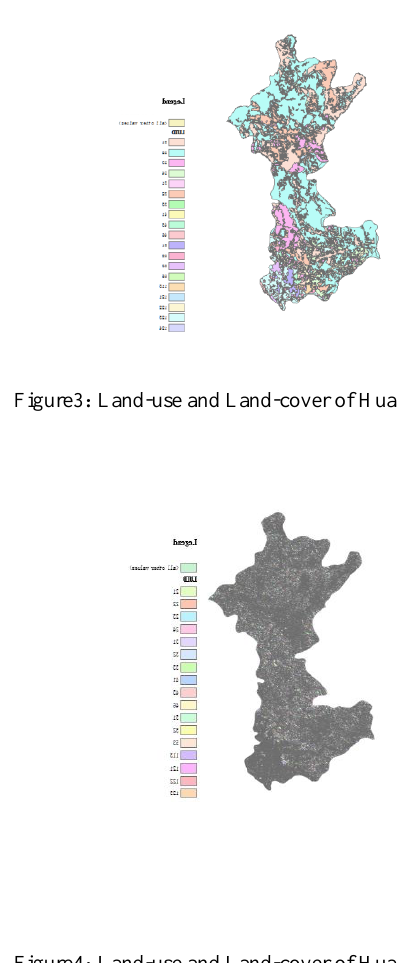
Figure1 ： Land-use and Land-cover of Huairouin 2000